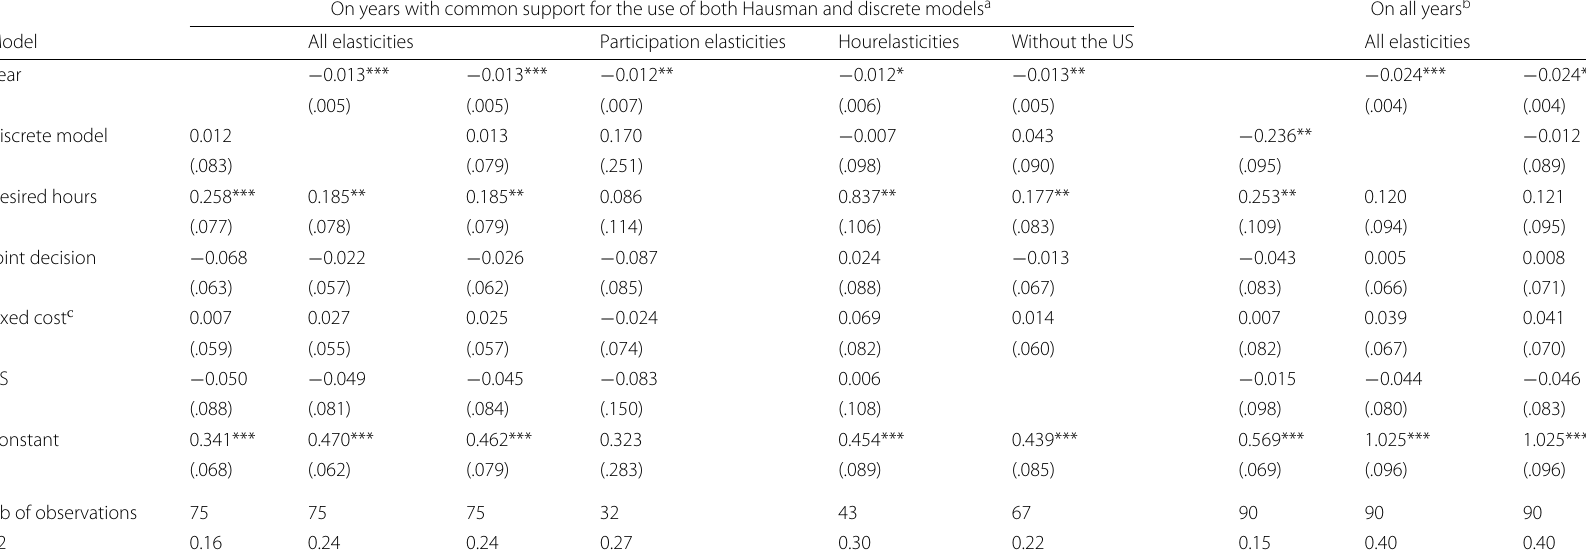
Table 4 Meta-regression of married women’s wage elasticities On years with common support for the use of both Hausman and discrete models a On all years